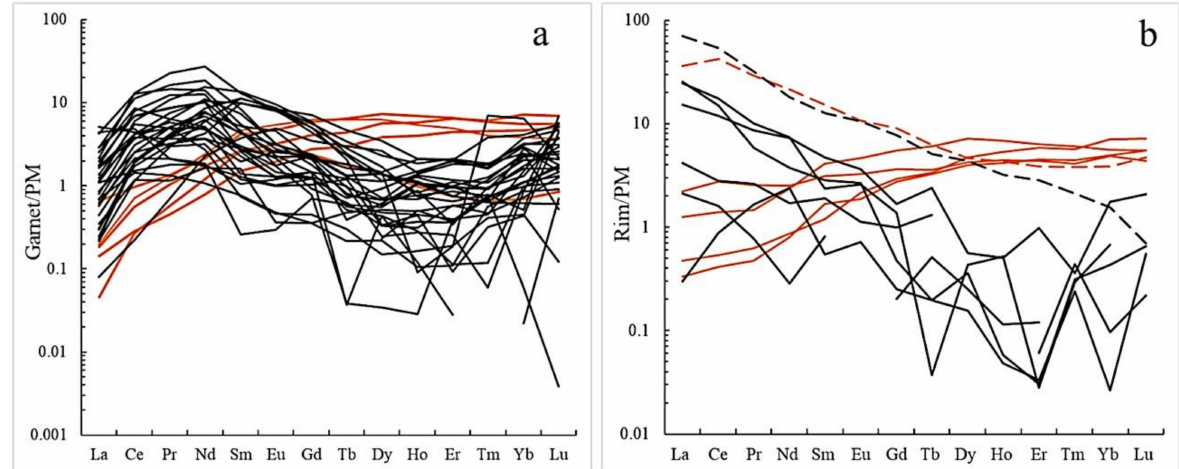
Figure 5. Primitive mantle normalized (after [45]) REE patterns of studied peridotite garnets and kelyphites: ( a ) Grt REE patterns (thirty-one MHD samples—black solid line, five ShP samples—orange solid line); ( b ) kelyphite REE patterns (six MHD rim1-2—black solid line; one MHD rim3—black dashed line; four ShP rim1/2—orange solid line, one ShP rim3—orange dashed